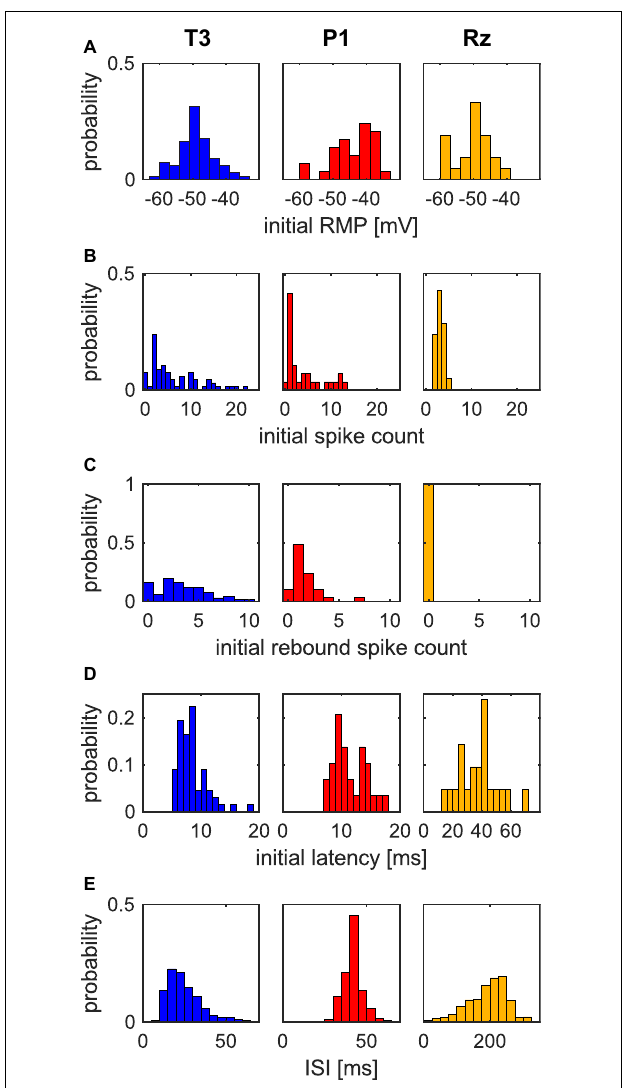
FIGURE 2 | Distributions of response properties for T3 ( n = 67), P1 ( n = 29), and Rz ( n = 21) cells in response to the stimulation protocol. (A) The initial RMP ranged from –65 to –35 mV for all cell types. (B) The initial spike count of T3 and P1 cells were variable, while all Rz cells fired consistently 3–5 spikes to +1 nA current. (C) Most T3 and P1 cells showed rebound spikes in trial 1, while Rz cells did not. (D) The initial first spike latency was characteristic for all cell types, with T3 cells having the shortest latencies and Rz cells the longest. Note that the x-axis-scaling is different for Rz. (E) ISI distribution over all trials. The distribution is skewed for T3 cells, while the ISI distribution of P1 cells is roughly symmetric around their preferred ISI of 42 ms. The distribution for Rz cells’ ISI is skewed, covering a large range. Note that the x-axis-scaling is different for Rz